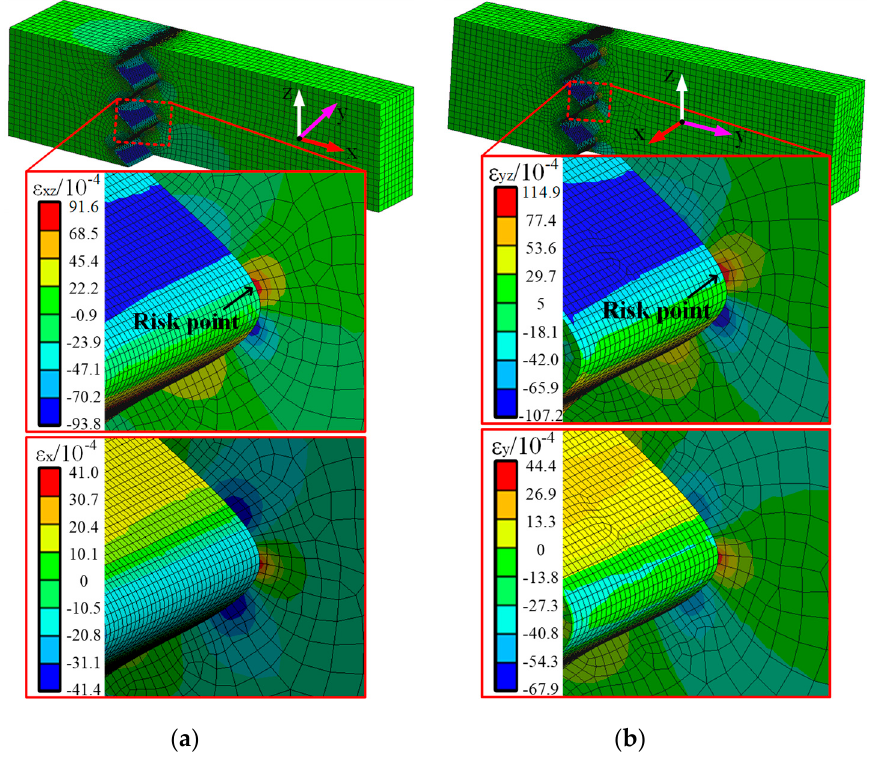
Figure 18. Strain contours of the slave model. ( a ) Leading edge; ( b ) Trailing edge.